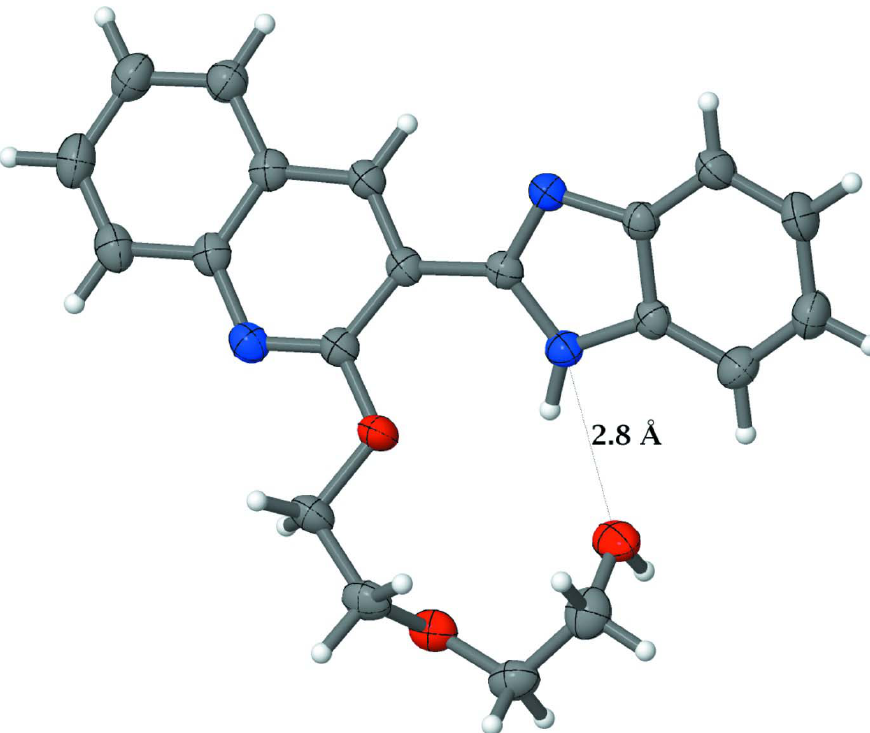
Enhanced figure of the title compound with displacement ellipsoids plotted at 50% probability